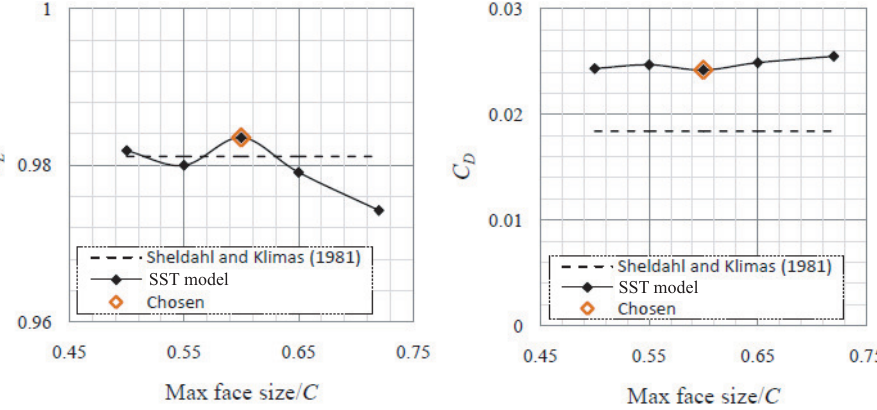
Figure 15. Variation in lift and drag as a function of maximum face sizing ( α = 10 ◦ , Re = 3.6 × 10 5 ).